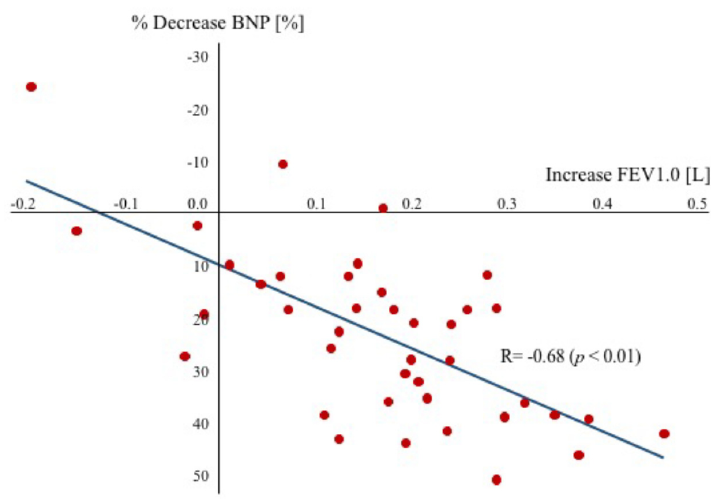
Figure 4. Relationship between the percentage decrease in plasma BNP levels and the absolute increase in FEV1.0. A significant relationship was observed between the percentage decrease in BNP and the increase in FEV1.0. BNP = brain natriuretic peptide, FEV = forced expiratory volume.